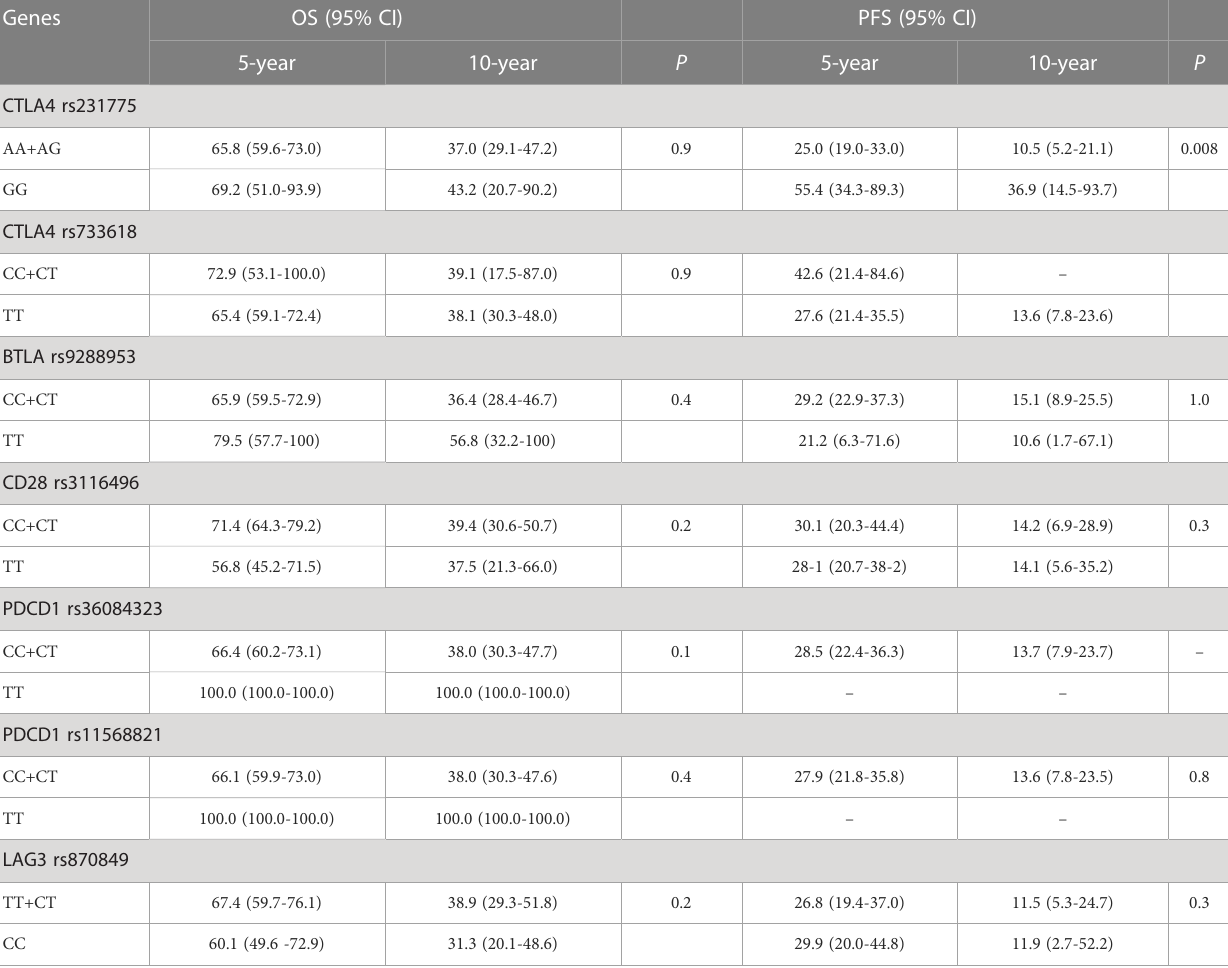
TABLE 3 Overall and progression-free survival of multiple myeloma patients according to immune checkpoint